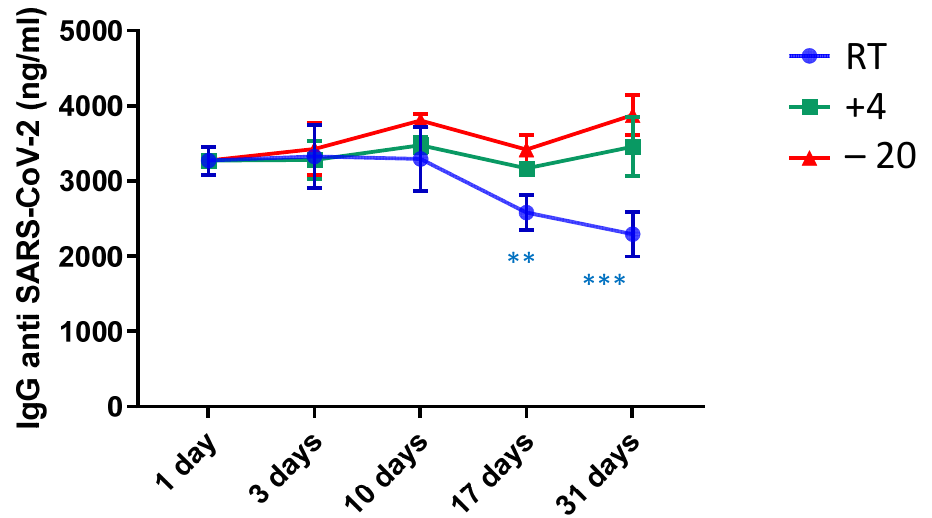
Figure 1. IgG anti SARS-CoV-2 measured up to 31 days after the sample collection at room temperature (RT), at +4 °C, at − 20 °C. ** means p -value at t -test < 0.001, *** means p -value at t -test < 0.0001.